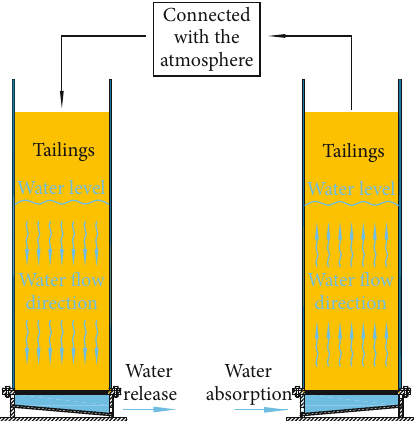
Figure 5: The schematic diagram of water absorption and release of